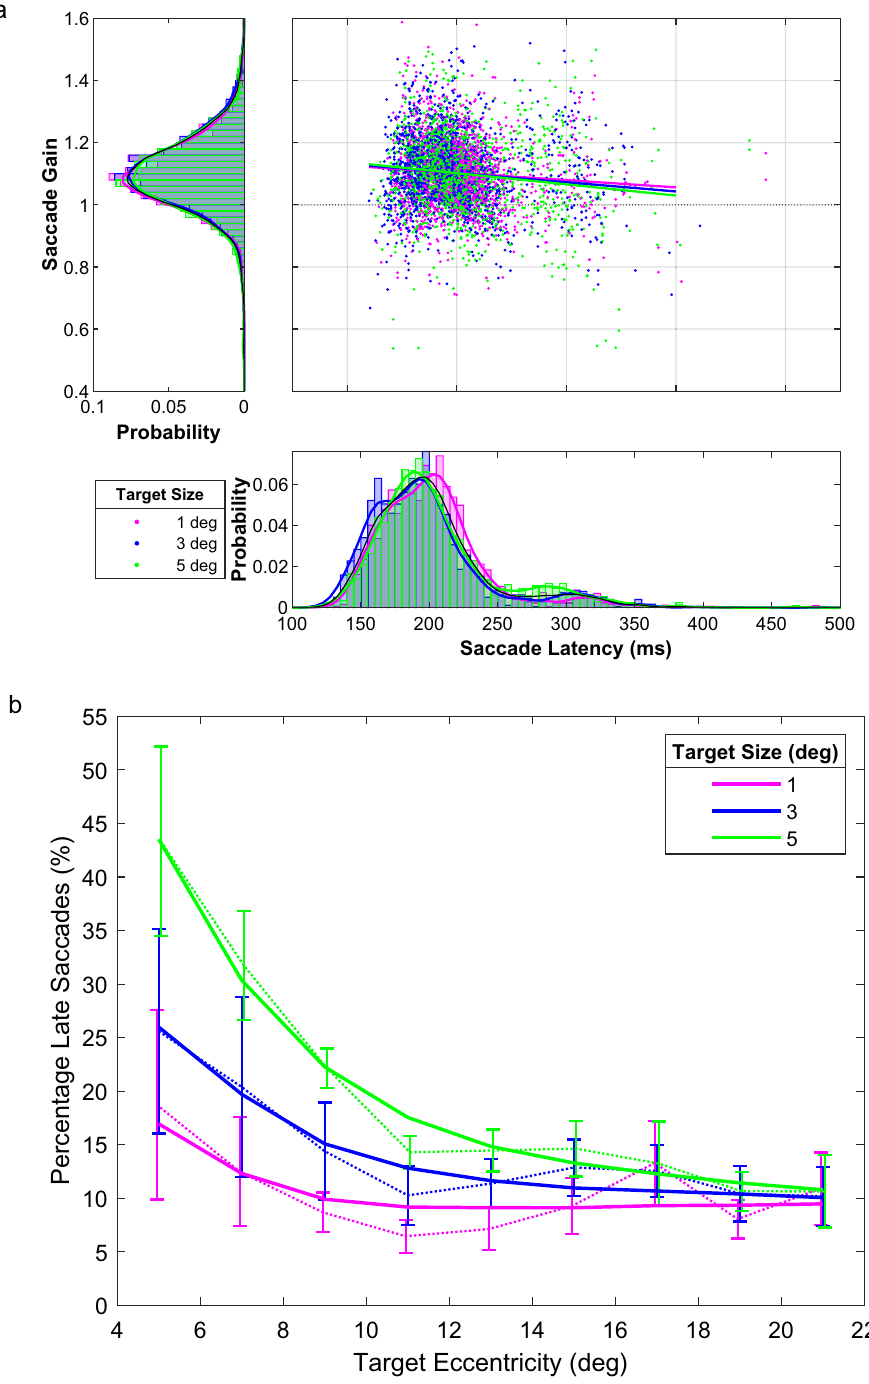
Figure 2. Latency and gain. ( a ) Scatter plot (center) showing saccade gain as a function of saccade latency for a single subject. Data are stratified by target size (color code). Solid lines are linear regression lines fitted to each of the data sets. The latency histograms (bottom) show bimodal distributions for a single subject with a group of early saccades and a group of late saccades. There are fewer late saccades than early ones. The gain histograms (left), which peak close to 1, illustrate the variability in saccade gain. This is also data from a single subject. ( b ) The percentage of saccades that were late for each target eccentricity and each target size. This is the average for all subjects. Error bars indicate ± 1